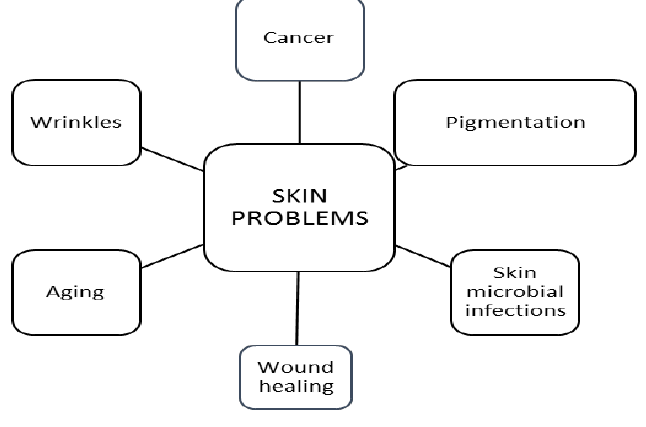
Figure 2. Major worldwide skin